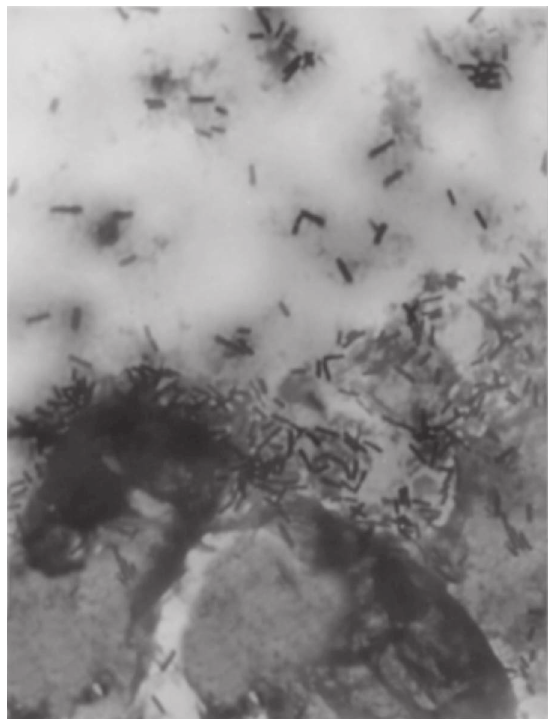
Figure 1 Lactobacilli and disrupted epithelial cells